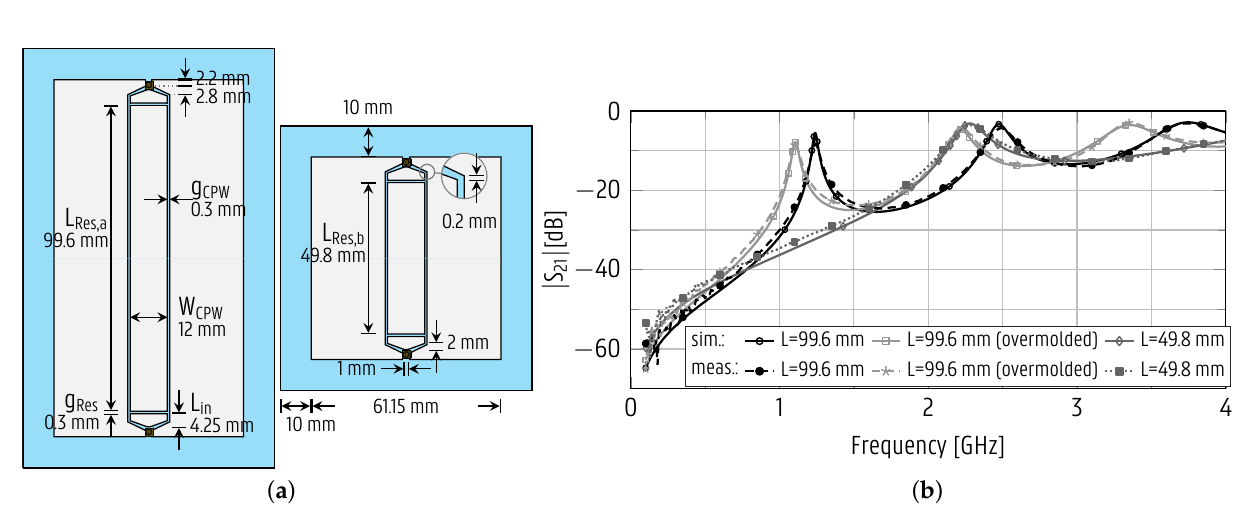
Figure 3. Substrate characterization resonators. ( a ) To-scale representation. The defined parameters are the same for both resonators, unless otherwise specified. ( b ) Magnitude of the transmission